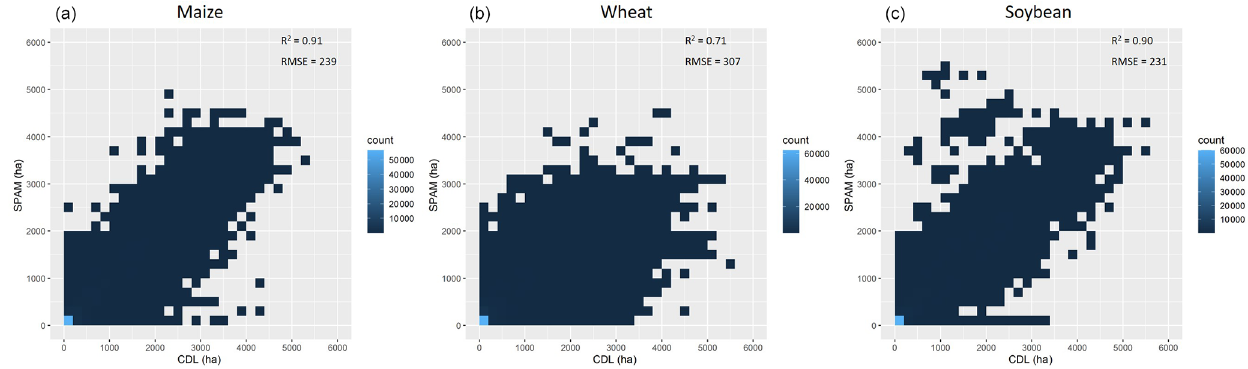
Figure 8. Grid-by-grid comparison of crop area for maize (a) , wheat (b) , and soybean (c) between SPAM2010 and CDL2010 in the conti- nental US.